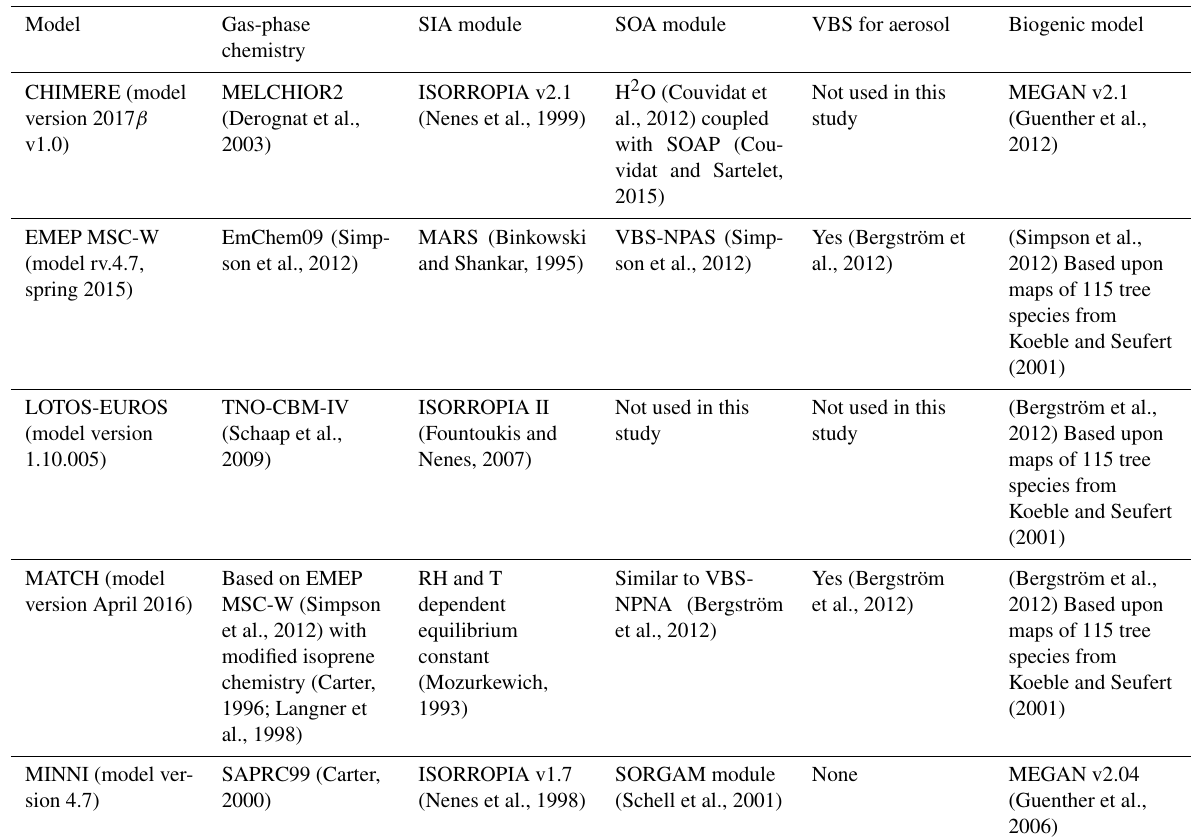
Table 1. Chemical, thermodynamic schemes and biogenic emission models used by the modeling teams in the EURODELTA-Trends exper-